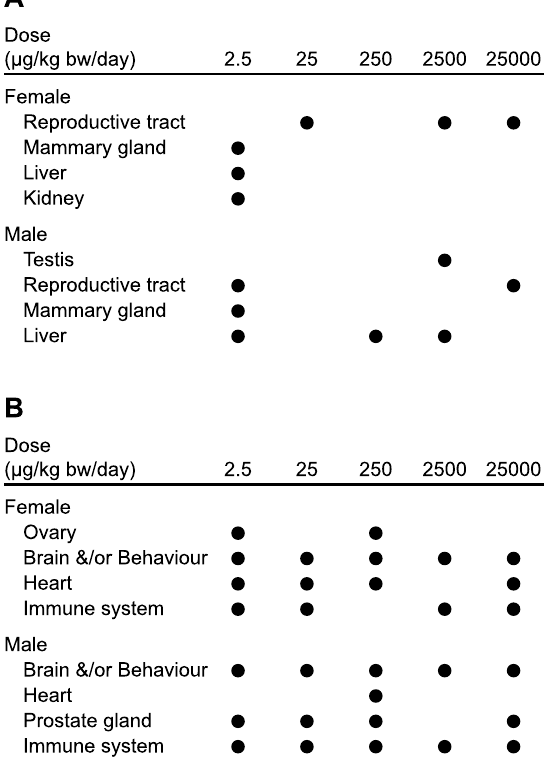
Figure 2. Outcomes from CLARITY-BPA. ( A ) Summary of CLARITY-BPA results from five BPA doses tested within the guideline studies. ( B ) Summary of CLARITY-BPA results from five BPA doses tested within the academic studies. Dots denote significant findings. Modified from Vandenberg LN et al.